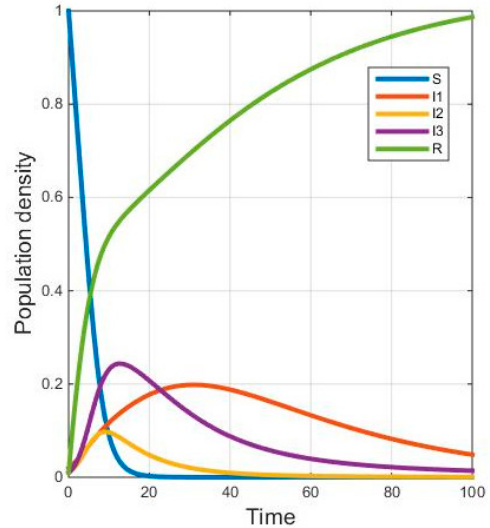
Figure 6. C hange trend of various groups under the enhanced media intervention of m 2 = 0.1. Figure 6. Change trend of various groups under the enhanced media intervention of m